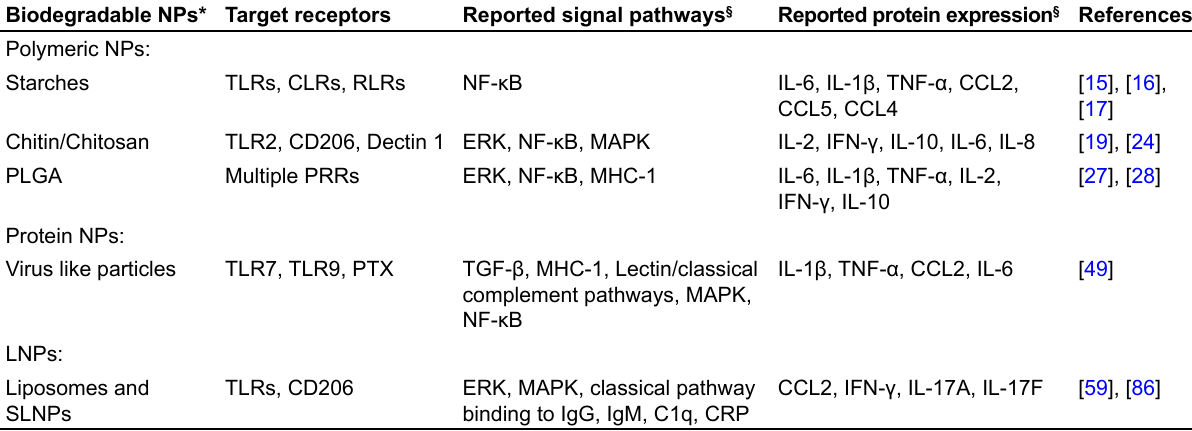
Table 1. Biodegradable NP-induced pathways Biodegradable NPs* Target receptors Reported signal pathways